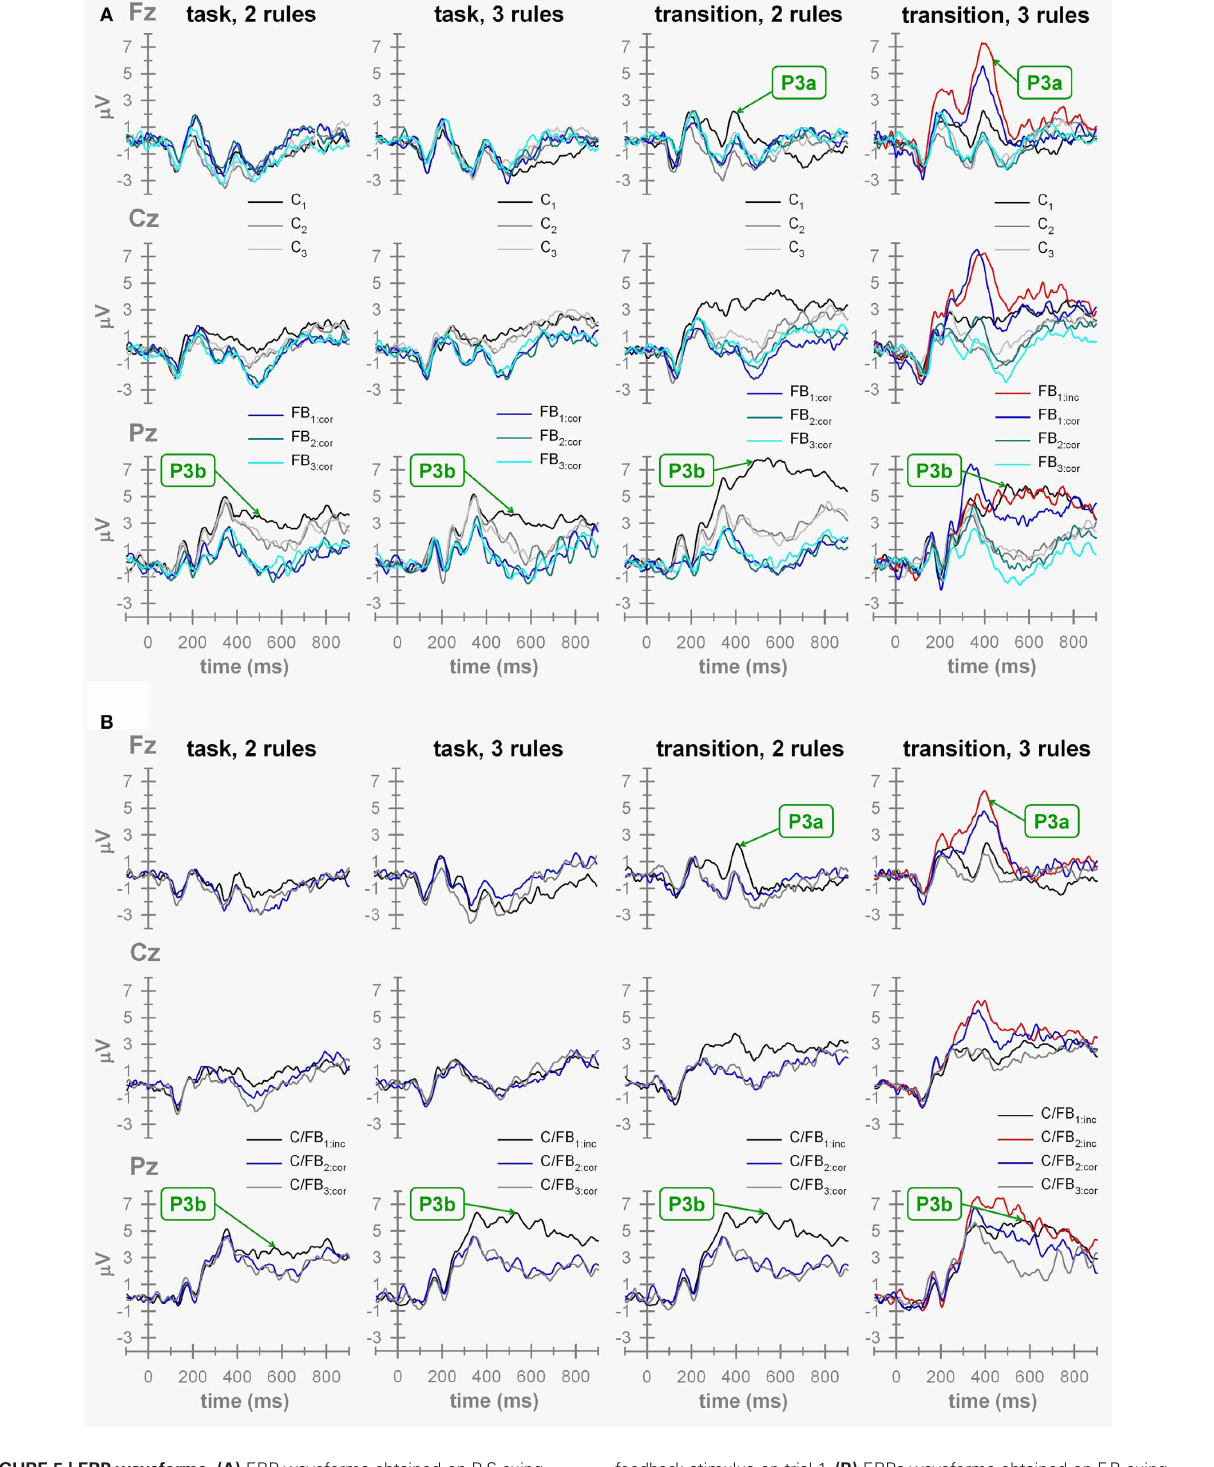
FIGURE 5 | ERP waveforms. (A) ERP waveforms obtained on P-S cuing conditions. “task,” task-cuing conditions (two-task, three-task conditions) with C x , task cue on trial x { x = 1 ... 3 } ; FB x : cor , correct feedback stimulus on trial x { x = 1 ... 3 } . “transition”, transition-cuing conditions (two-task, three-task conditions) with C x = task cue on trial x { x = 1 ... 3 } ; FB x : cor = correct feedback stimulus on trial x { x = 1 ... 3 } and FB 1 : inc , incorrect